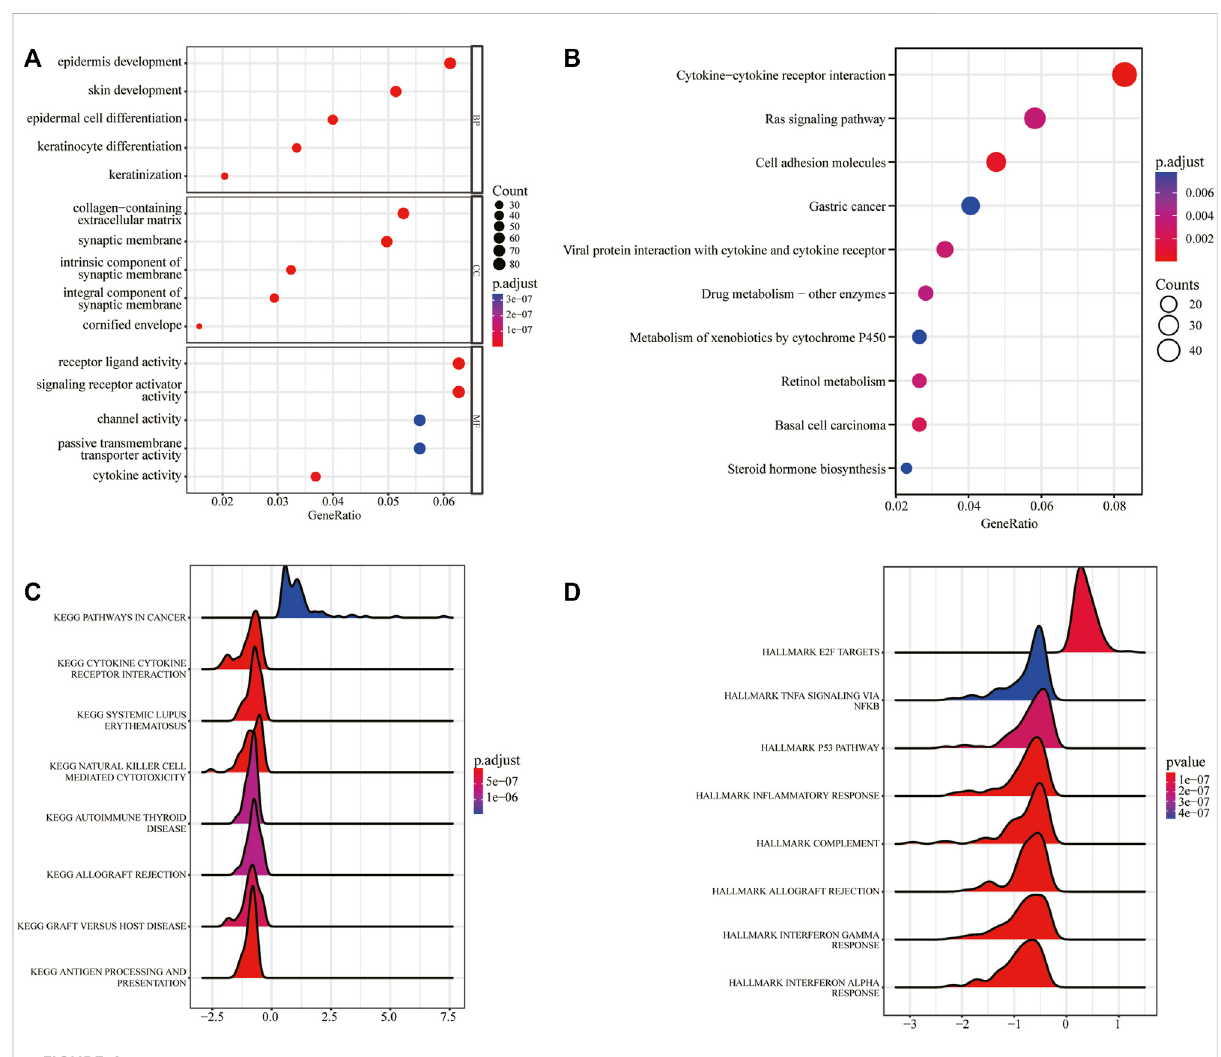
FIGURE 4 GO/KEGG/GSEA analysis based on DEGs between the pyroptosis subtypes. (A) GO functional enrichment analysis. (B) KEGG pathway enrichment analysis. (C) Gene set enrichment analysis, x -axis represents gene ratio, y -axis represents KEGG pathways, and the color represents the p -value. (D) Gene set enrichment analysis, x -axis represents gene ratio, the y -axis represents HALLMARKs, and the color represents p